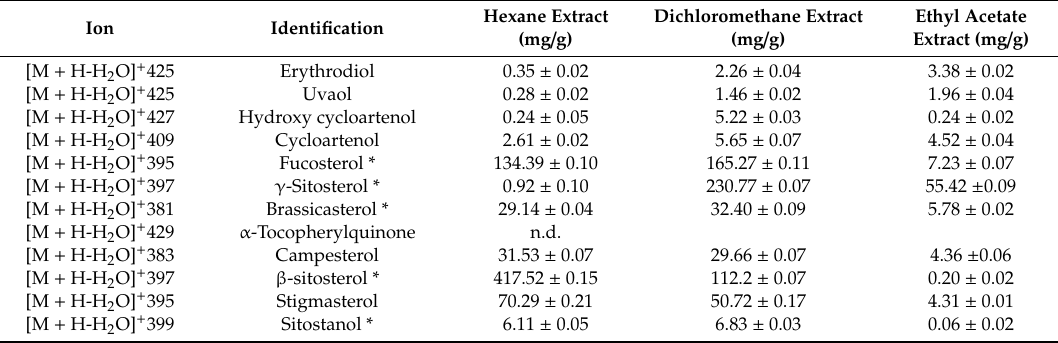
Table 6. Quantitative data on phytosterol in fractionated extracts of G. diversifolia , *for phytol, quantitative data were obtained by GC-MS.